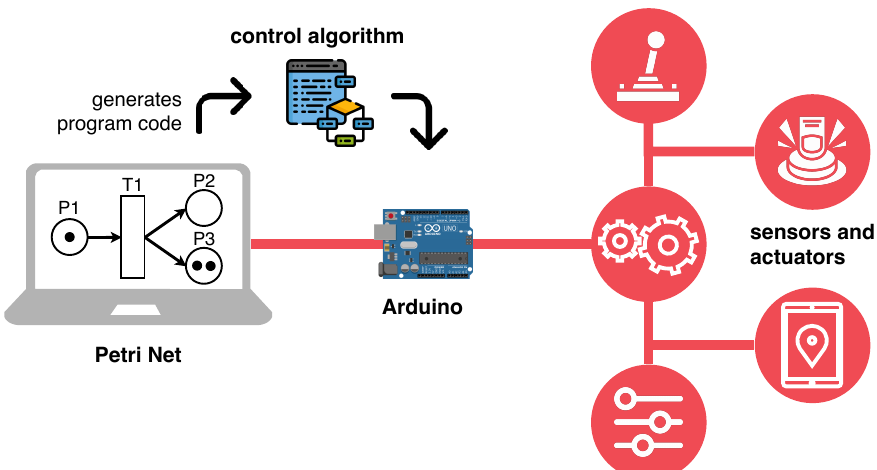
Figure 3. “PetriNet editor + PetriNet engine”—Scheme of proposed and implemented solution. The use-case diagram of the developed software tool is depicted in Figure